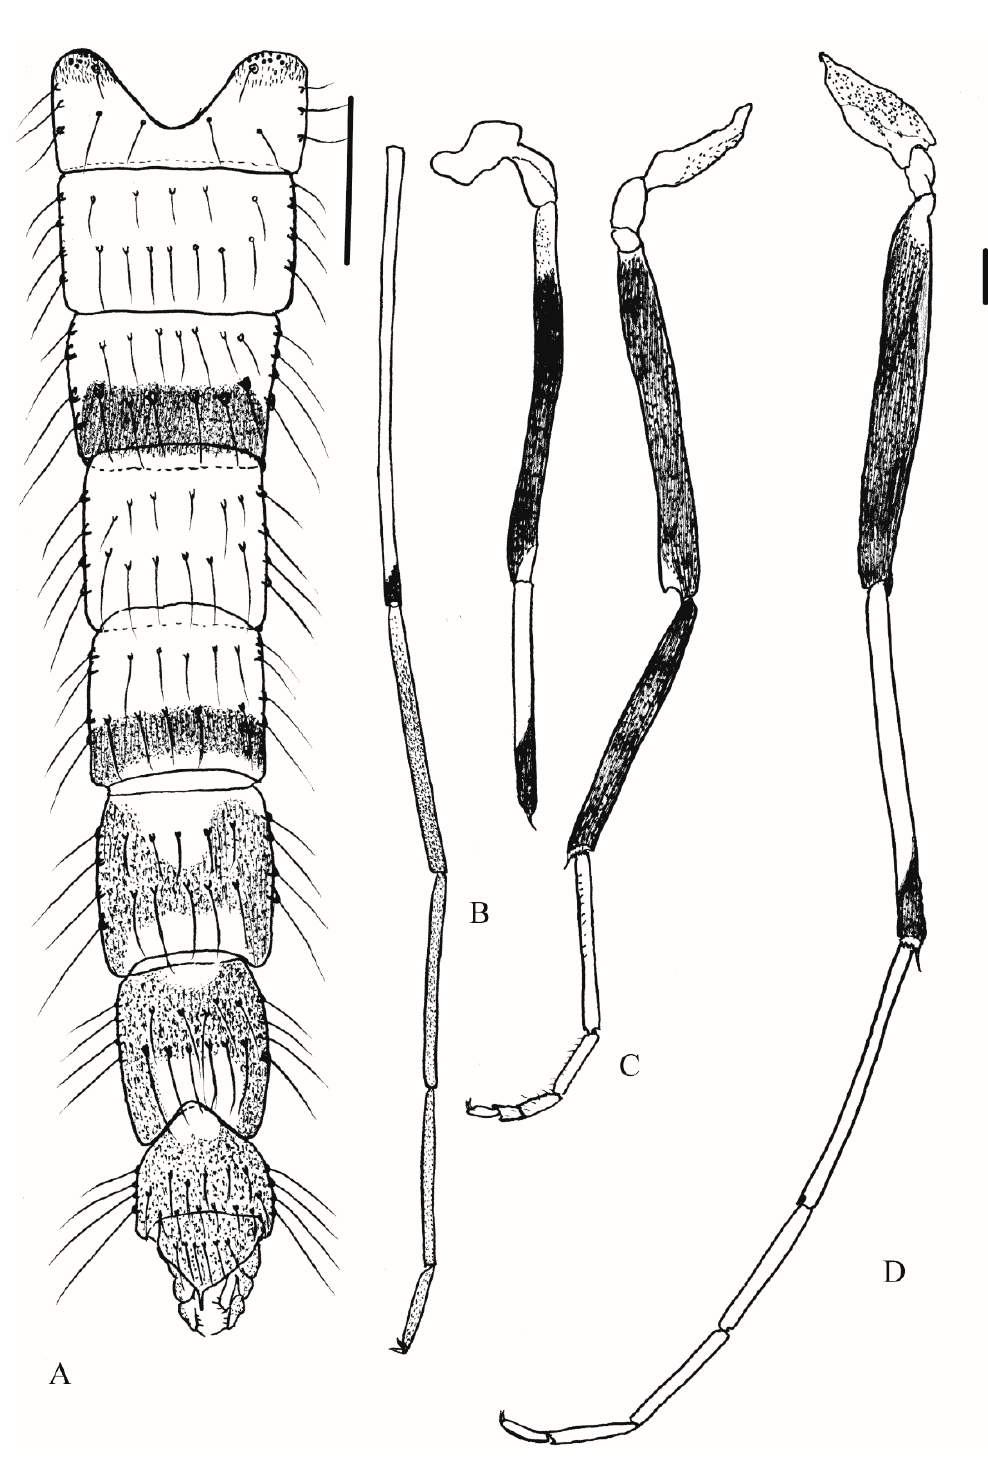
Figure 5. Y. balteatus sp. n. , male. Illustration. ( A ) abdomen; ( B ) fore legs; ( C ) mid legs; ( D ) hind legs. Scale bar: A, 250 µm; B–D, 100 µm.